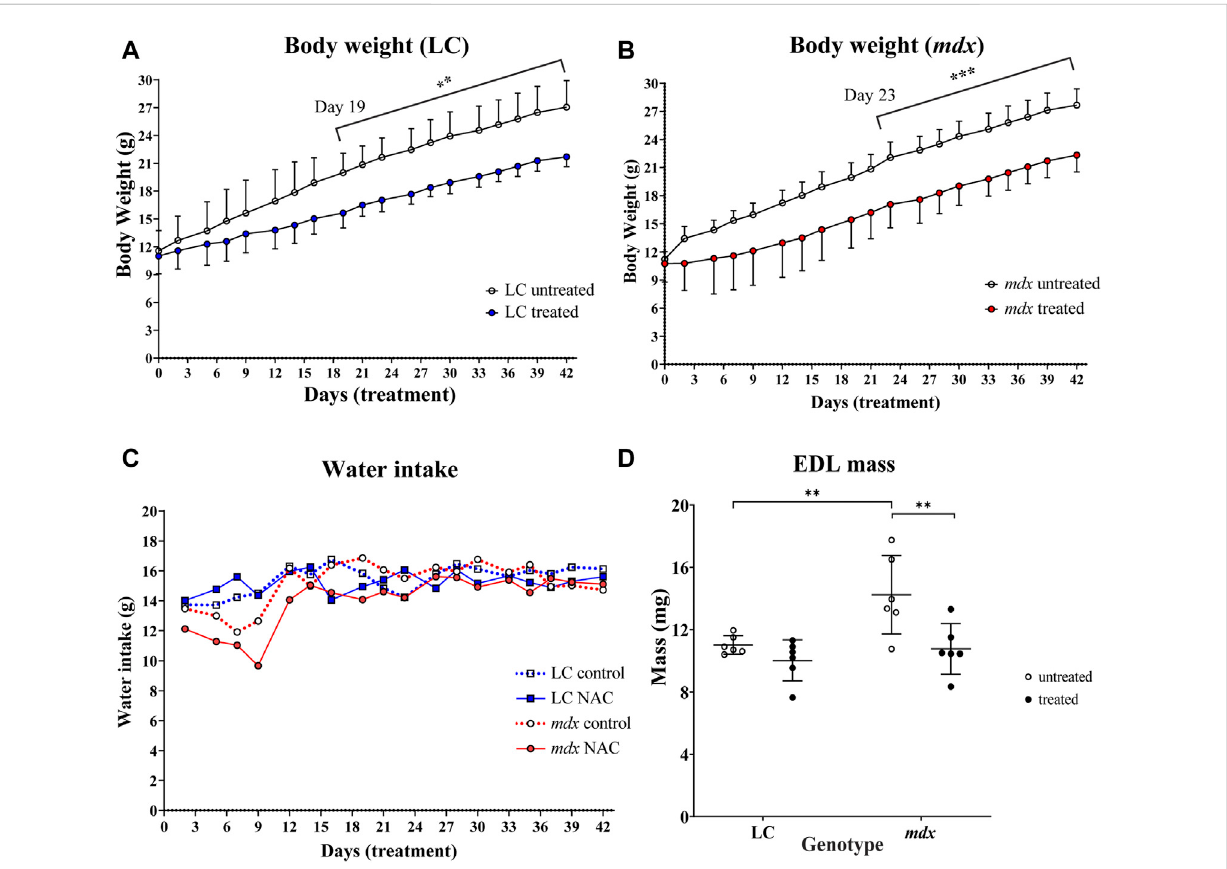
FIGURE 1 Effect of NAC on body weight (A) LC (B) mdx (C) water intake of animals throughout treatment period and (D) muscle mass (A) shows signi fi cant differences in weight gain from day 19 onward for LCs untreated vs. NAC treated ( p = 0.0015). (B) shows signi fi cant differences in weight gain from